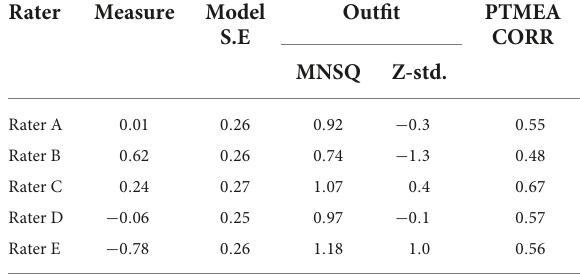
TABLE 5 Analysis of fit statistics for